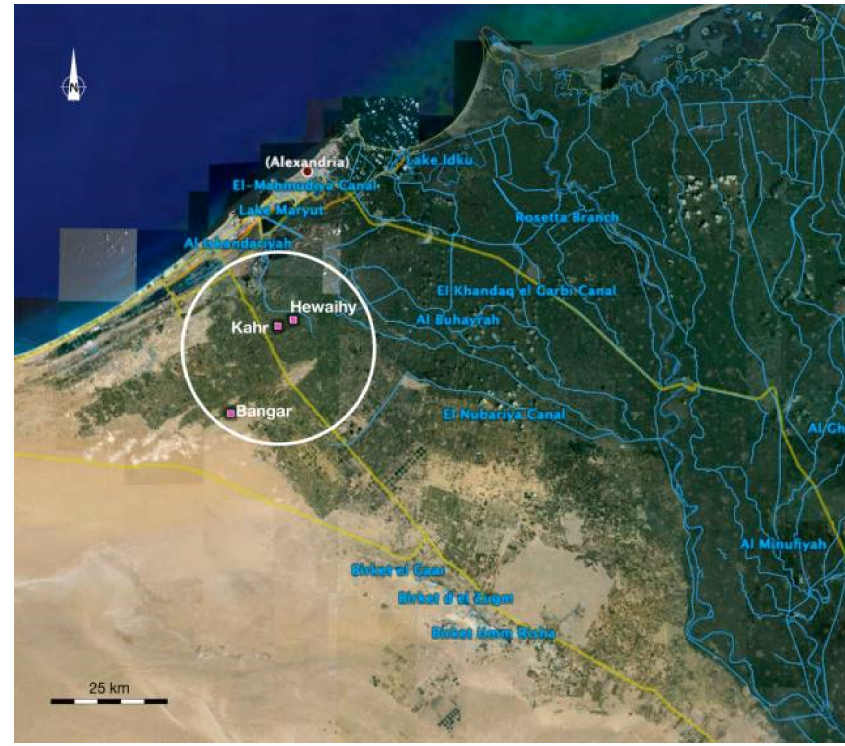
Figure 1. A map of the three investigated study areas south-west Nile Delta, Egypt. Field campaigns aimed to gather ground reference data of wheat crops, which were collected randomly at different sites. All types of common irrigation systems are used across the entire study site (traditional surface, sprinkler and drip irrigation). Farmers sometimes use alternative sources of fresh water (e.g., agricultural drainage water) to irrigate crops at the tail end of the irrigation canal system, even with the risk of an increased salinity